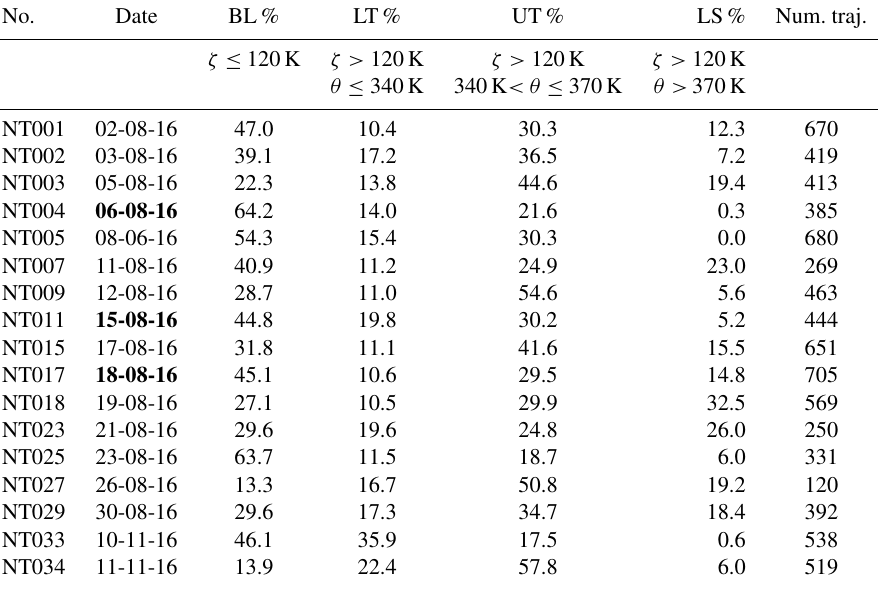
Table 2. Contributions of the origin of the air masses found in the ATAL using 40-day backward trajectories according to sources in the boundary layer (BL), in the lower troposphere (LT), in the upper troposphere (UT) and in the lower stratosphere (LS). The number of backward trajectories (starting within the ATAL layer) calculated along each balloon profile is given in the last column. In the second and third row, the selection criteria for BL, LT, UT and LS are listed. Trajectories are considered to end in the BL when they are located for the first time below about 2–3km (i.e. vertical hybrid coordinate ζ ≤ 120K). The location of this point is referred to as the “end point” of the trajectory in the model boundary layer. For the remaining trajectories ending at atmospheric altitudes ( ζ > 120K), a potential temperature criterion ( (cid:50) ) is employed to discriminate between origins in LT, UT and LS. The dates of three balloon flights representing typical situations encountered during the measurements in August 2016 are marked in bold type: the case of an established ATAL (6 August 2016), a case without the observation of an ATAL (15 August 2016) and a case in which the measurements are heavily influenced by air masses uplifted in a tropical cyclone (18 August